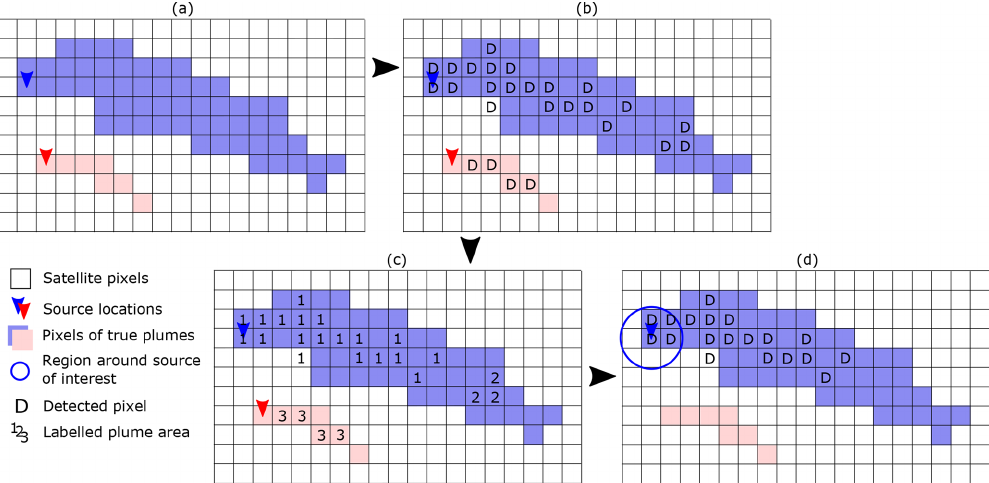
Figure 3. Schematic of the processing steps of the plume detection algorithm. (a) A large (blue) and a small plume (red) with sources marked by arrows are located within the satellite overpass. (b) Pixels detected based on the Z test are marked with “D”. (c) Connected pixels are given a unique number each denoting a different plume. (d) All plumes not connected with the source of interest (blue circle) are rejected.